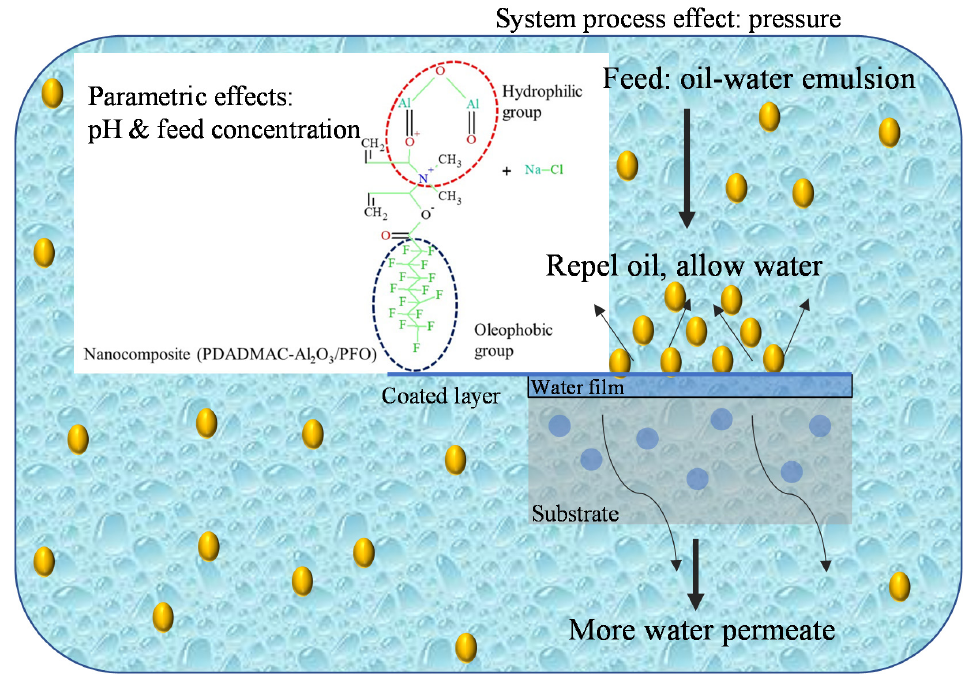
Figure 3. Mechanism separation of ultrafiltration ceramic membrane for the emulsified oily water.